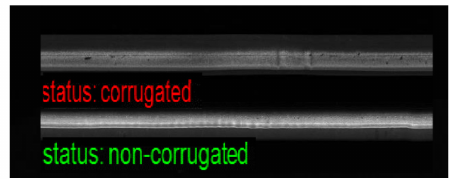
Figure 11. Misclassified samples FP and